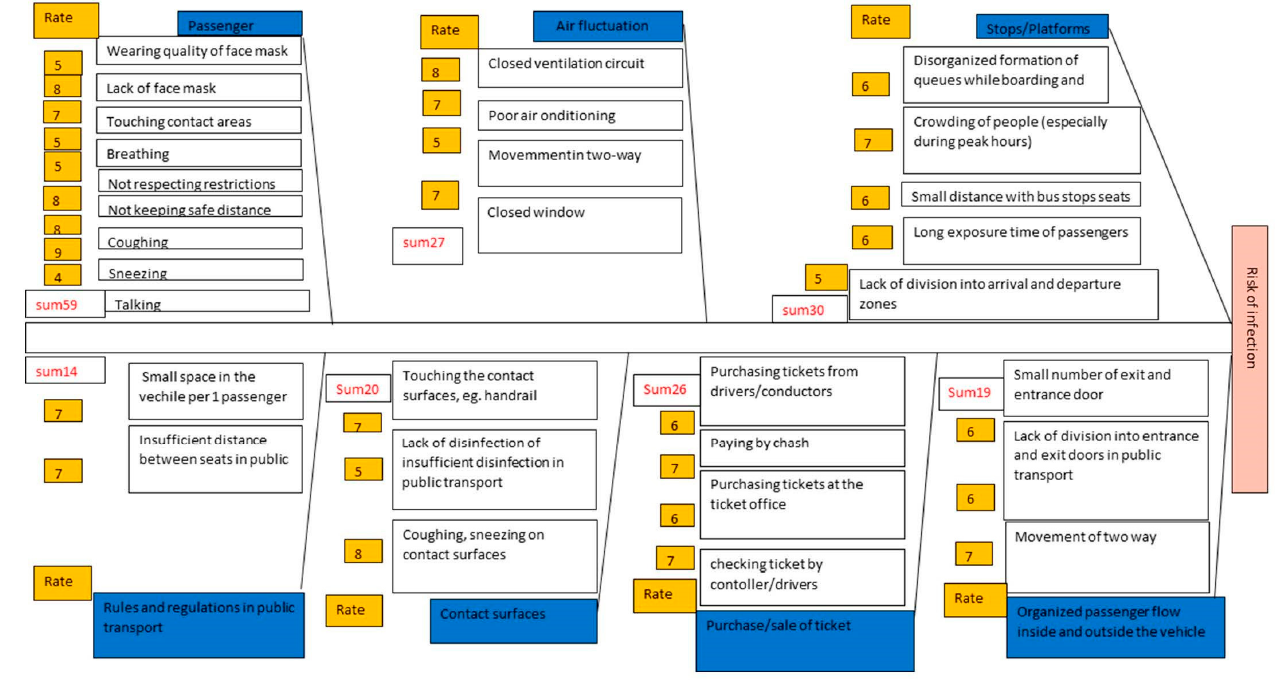
Figure 2. Fishbone diagram identifying the causes and effects of the risk of infection, members of the project on the identification of epidemic hazards in transport.